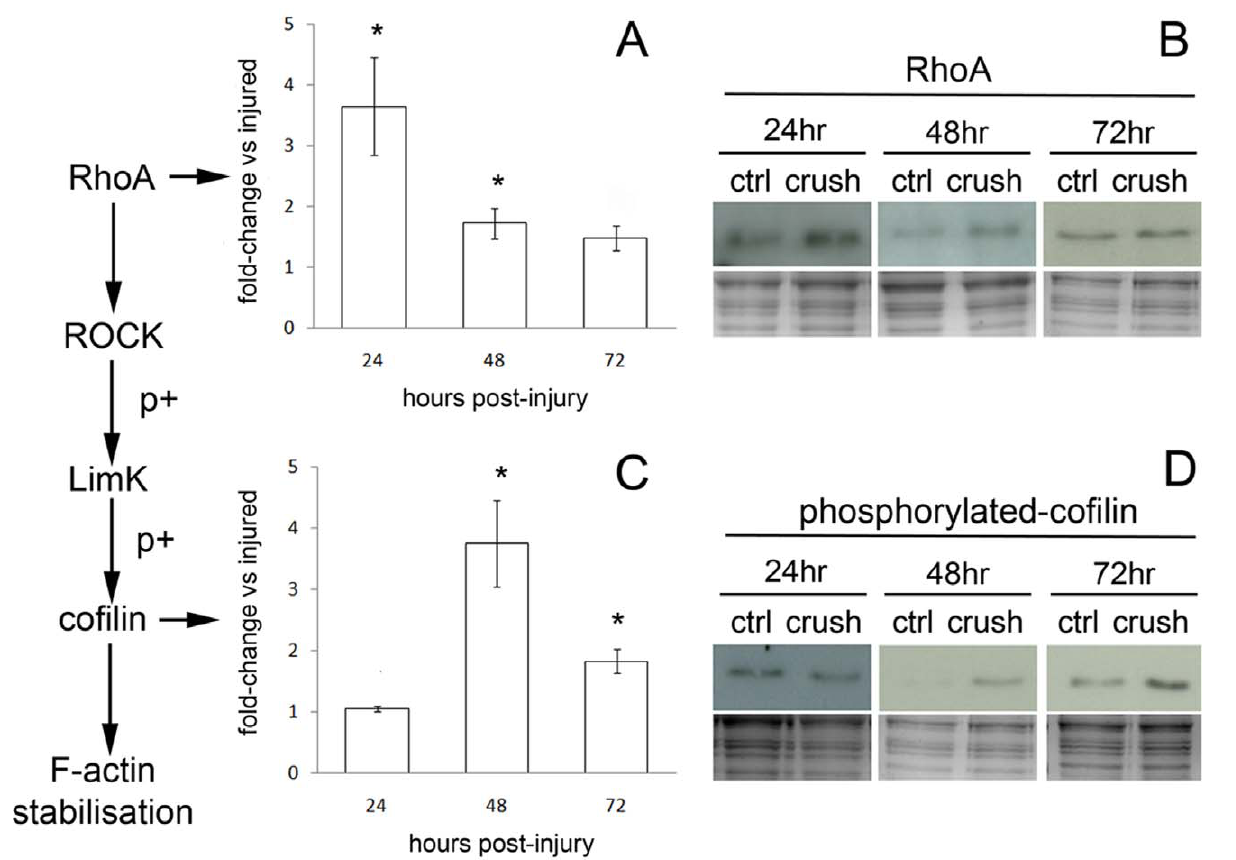
Figure 3. RhoA and phosphorylated cofilin expression are modulated in axoplasm-enriched samples from injured optic nerve. Injured optic nerves and control contralateral nerves were collected at 24, 48 and 72 hrs and axoplasm-enriched samples generated. Immunoblots for RhoA and phosphorylated cofilin are shown, with coomassie stained gels to determine loading (B&D). Quantification is presented as fold-change vs injured and represent 3 independent experiments 6 SEM (A&C); one-way ANOVA plus Tukey post hoc test was used to assess significance, and where indicated (*) equals p , 0.05. Immunoblotting for RhoA protein revealed a significant increase at 24 hrs, which persisted up to 48 hrs following injury (A&B). Following the increase in RhoA we observed a lag of 24 hrs before a significant increase in phosphorylated cofilin was detected that persisted until 72 hrs post-injury (C&D).